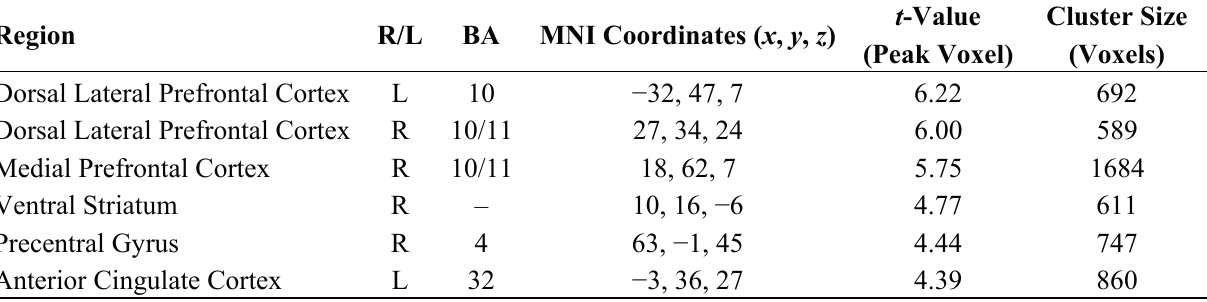
Table 2. Whole-brain gray matter volume analysis.